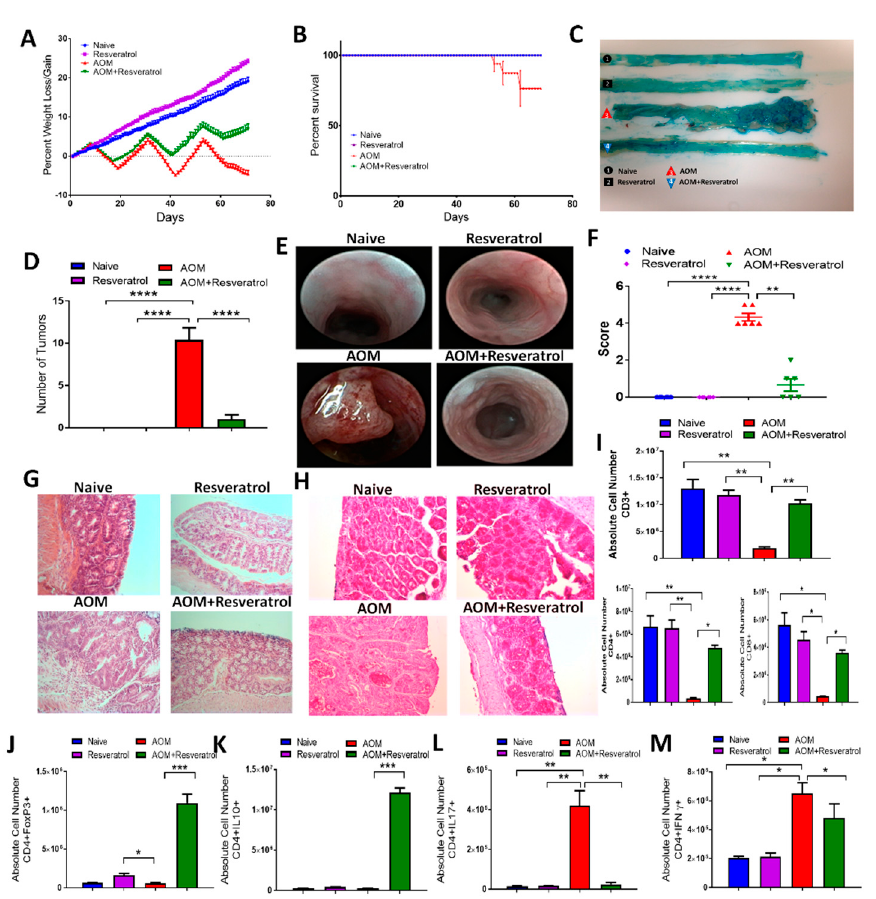
Figure 1. Treatment with resveratrol reduces clinical symptoms and alters T cell phenotype in azoxymethane (AOM)-induced colorectal cancer (CRC) model. C57BL/6 mice were injected intraperitoneal with 10 mg of AOM followed by 3 cycles of 2% DSS, to induce CRC. Experimental groups consisted of: Naïve ( n = 6), Resveratrol ( n = 6), AOM ( n = 6), and AOM+Resveratrol ( n = 6). Clinical parameters consisted of percent weight loss ( A ) and survival ( B ). ( C ) Representative colons stained with 1% Alcian blue. ( D ) Bar graph depicting number of tumors counted in each experimental group. ( E ) Representative colonoscopic images from experimental groups. ( F ) Bar graph depicting scores after examination of tumor polyps detected during colonoscopies. ( G ) Representative colon sections stained with H&E; scale bar = 100 µM at 40x objective. ( H ) Representative colon sections with PAS staining; scale bar = 100 µM at 40x objective. ( I ) Bar graphs depicting absolute cell numbers in mesenteric lymph node (MLN) for all T cells (CD3+), T helper (CD3+CD4+), and cytotoxic (CD3+CD8+) T cells. ( J – M ) Bar graphs depicting absolute cell numbers in MLN for Tregs ( J ), Th cells producing IL-10 ( K ), Th17 ( L ), and Th1 ( M ) cells. Significance ( p -value: * p < 0.05, ** p < 0.01, *** p < 0.005, **** p < 0.001) was determined by using one-way ANOVA and post-hoc Tukey’s test for bar/dot graphs, Mann–Whitney test for weight data, and log rank test for survival curve. Data are representative of at least 3 independent experiments.